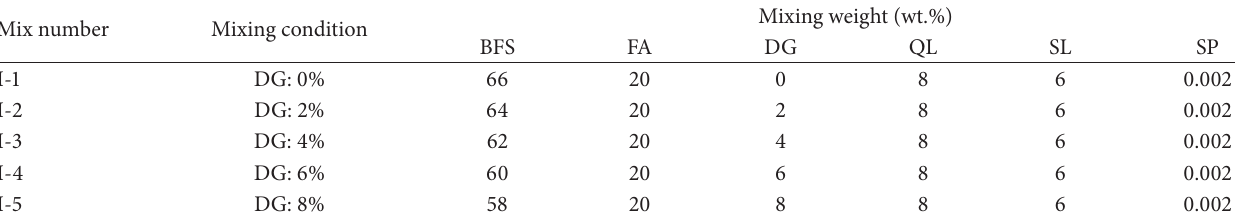
Table 6: Noncement binder mixing ratio.